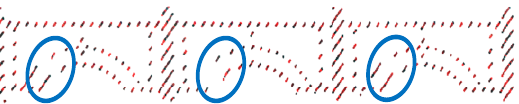
Figure 21. Pipes on which points are sparse